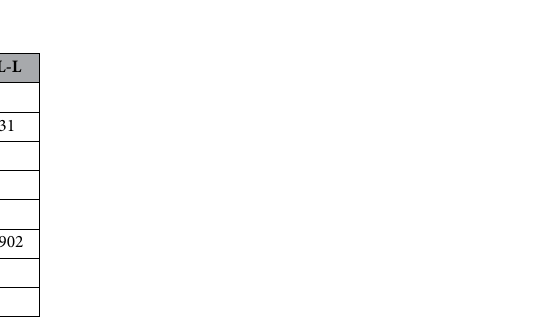
Table 4. The various band gaps at zero pressure for K 2 SeBr 6 and K 2 PtBr 6